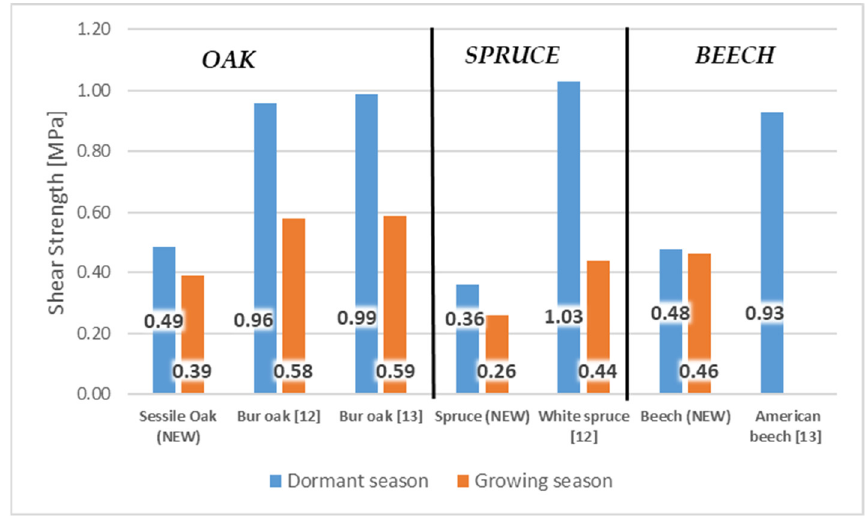
Figure 5. Comparison values of shear strength during dormant and growing season in longitudinal direction with similar wood species.